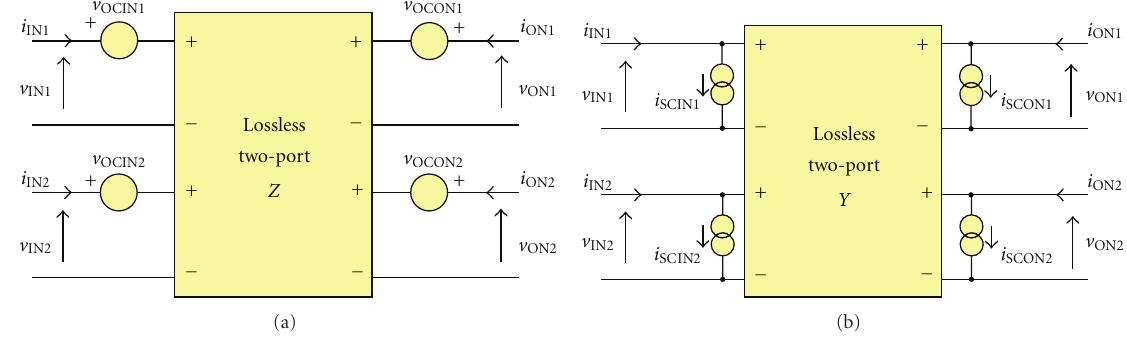
Figure 2: Equivalent circuit for a noisy MIPMOP